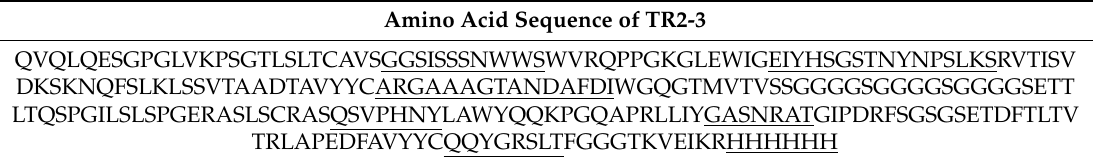
Table 2. IMGT–VQUEST sequence analysis of TR2-3. Amino Acid Sequence of TR2-3